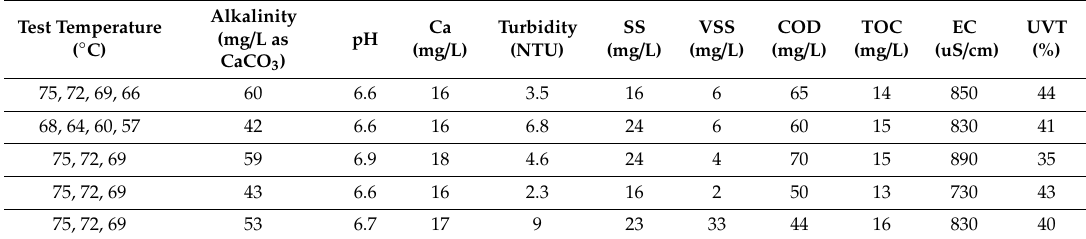
Table 2. Water quality on high flow rate (1100 L / min) challenge tests